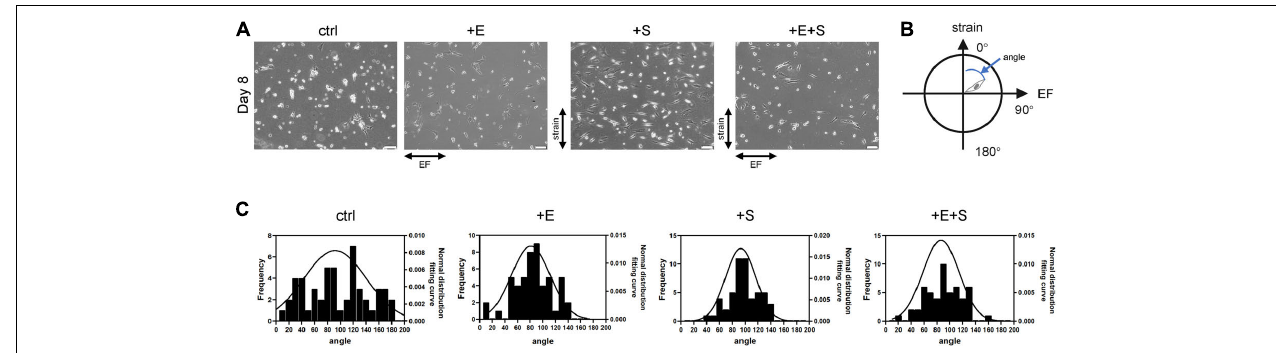
FIGURE 2 | BMSC reorientation under cyclical strain and electrical field stimulation. (A) The change of cellular orientation under static control (ctrl), electrical stimulation (+E), strain (+S), and co-stimulation (+E + S). Scale bar, 100 µ m. The directions of strain and electrical field were indicated by arrows. (B) Schematic illustration indicates cell angle. The vertical upward direction was defined as 0 ◦ , and the horizontal right direction was defined as 90 ◦ . (C) Distribution of cellular orientation. The line was the normal distribution fitting curve.